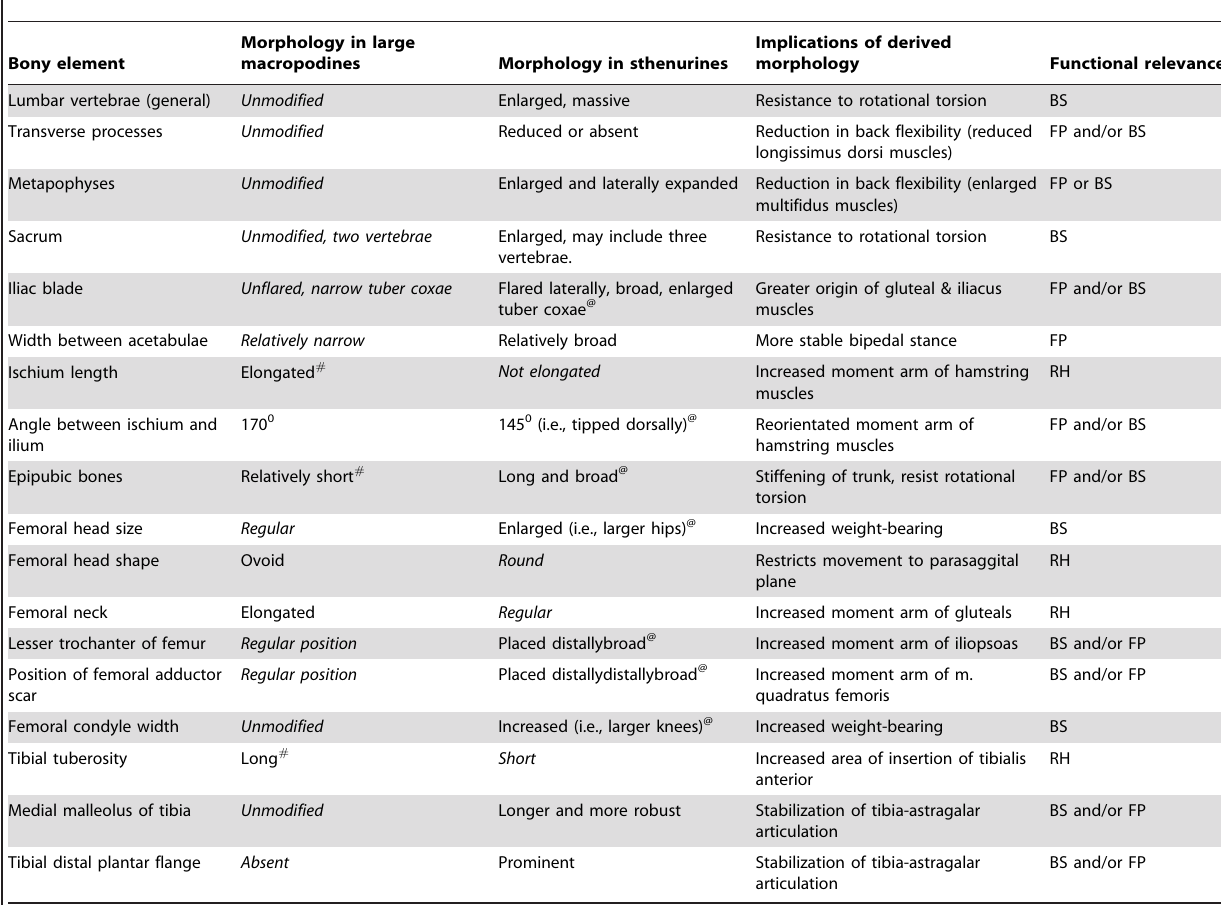
Table 6. Summary of important differences between sthenurines and large species of Macropus 1: Lumbar vertebrae, pelvis and proximal limb